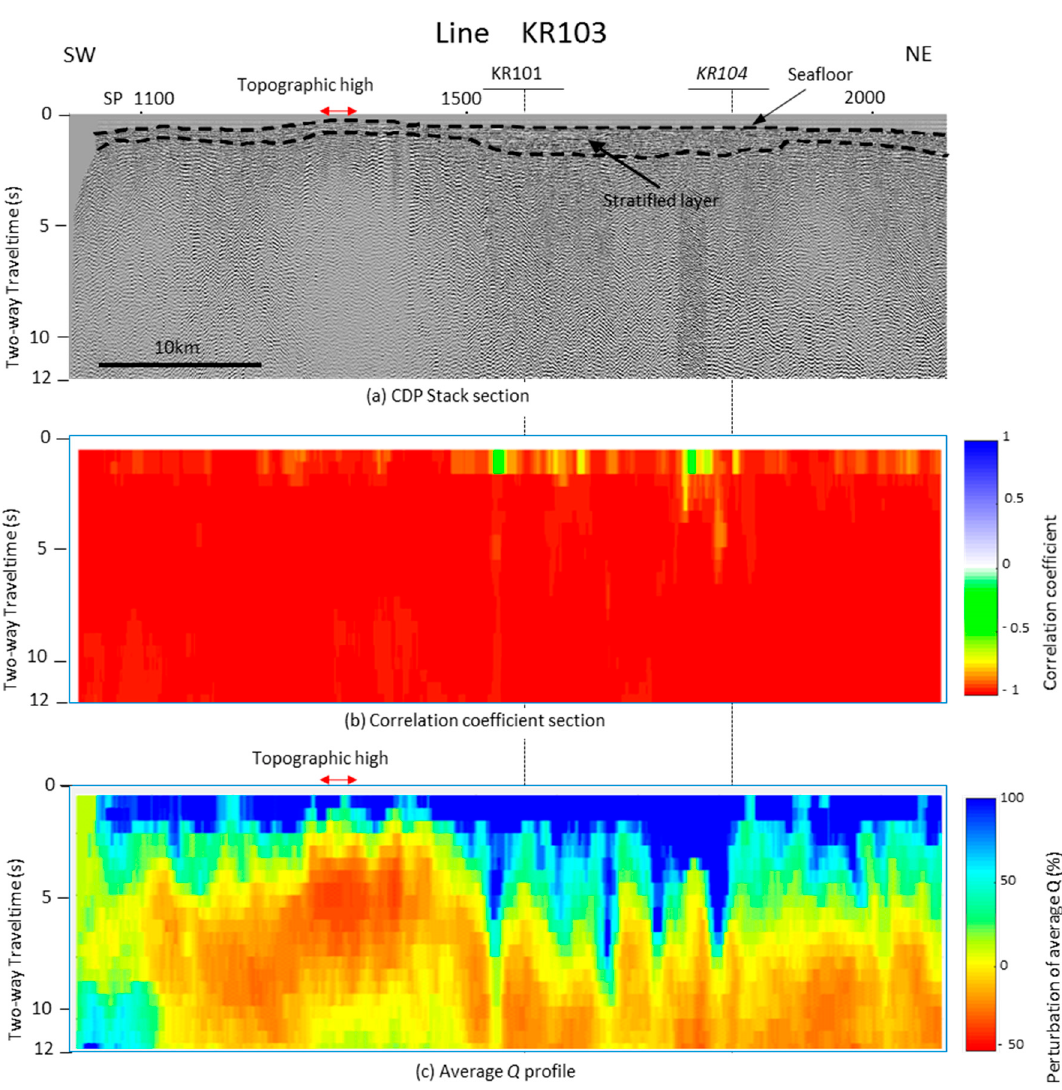
Figure 8. CDP stack section ( a ), correlation coefficient section ( b ), and average Q profile ( c ) of line KR103. The stratified layer with continuous reflections was imaged in the shallowest part on the CDP stack section; however, no reflections can be observed below the layer. The correlation coefficient section shows that almost all of the correlation coefficients in the linear approximation of gradient p represent highly negative correlations (less than − 0.8). An up-warping high attenuation anomaly can be observed on the average Q profile on the topographic high (see Figure 1).